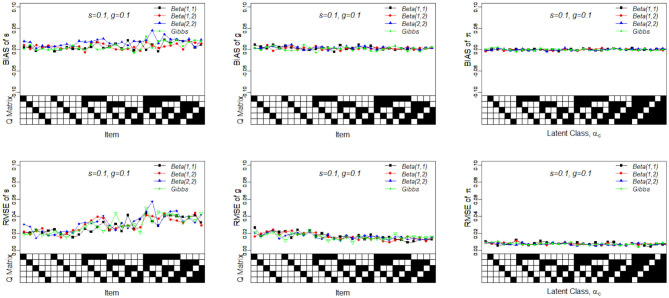
Bias and RMSE of slip, guessing, and the latent membership parameters based on different conjugate priors. Given on the X-axis are the Q-matrix and αc, where a black square denotes the presence of the attribute.